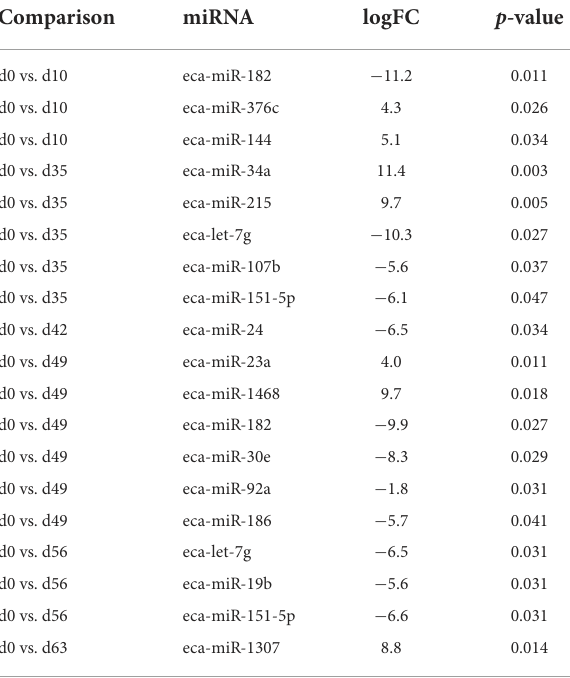
TABLE 1 Differentially expressed miRNAs compared to day 0 in plasma-derived